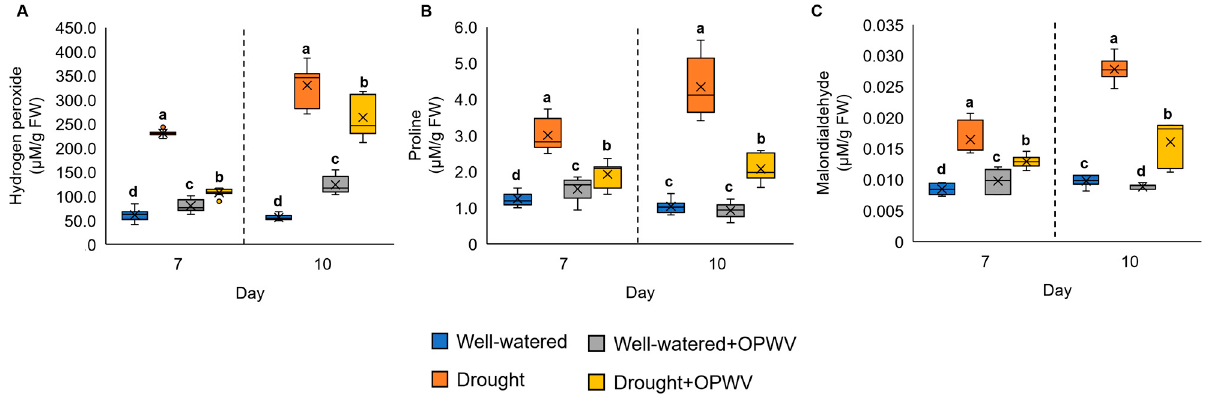
Figure 6. The hydrogen peroxide (H 2 O 2 ), proline and malondialdehyde (MDA) contents in the well-watered and drought-stressed Pandanus amaryllifolius plants with or without OPWV for 7 and 10 days. ( A ) H 2 O 2 . ( B ) Proline. ( C ) MDA. The letter labelled on the mean value indicates a significant level between treatments based on the one-way ANOVA, followed by the post hoc test when its p -value < 0.05. The letter ‘a’ above the bars indicates the highest value, followed by ‘b’, ‘c’, and ‘d’. The ( × ) labelled in the box plot indicates the mean value of the treatment, while the ( • ) refers to the outlier value of the replicates .